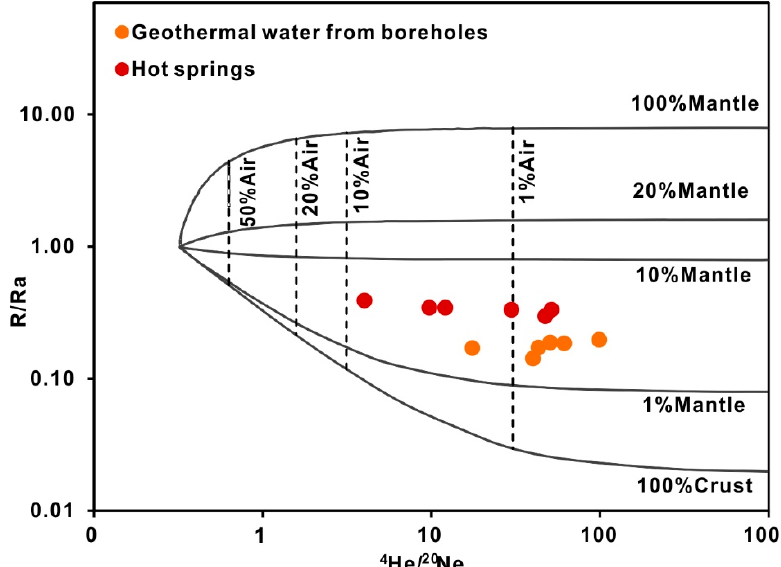
Figure 10. Diagram of the 4 He/ 20 Ne ratios vs the R/Ra ratios. The three end members used to build the mixing line are the atmosphere (R/Ra = 1, 4 He/ 20 Ne = 0.318) [63], mantle (R/Ra = 8, 4 He/ 20 Ne = 1000), and continental crust (R/Ra = 0.02, 4 He/ 20 Ne = 1000) [63,69]. The 3 He/ 4 He ratio is usually expressed as R. The 3 He/ 4 He ratio in the atmosphere, Ra, is 1.384 × 10 − 6 [63].